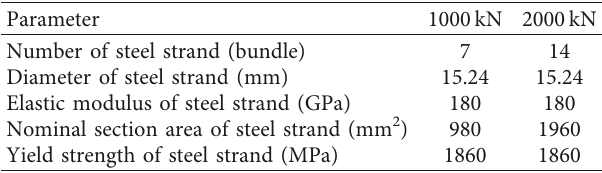
Figure 6: The cross-sectional layout of the prestressed anchorage cables installed in the slope. Table 4: Parameters of the prestressed anchorage cable.